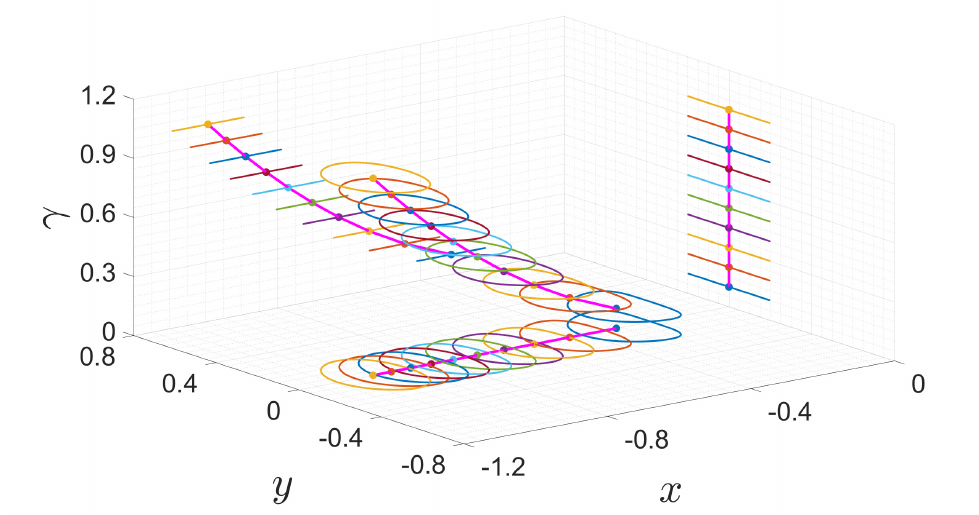
Figure 7. Third-order periodic orbits and their planar projections under different γ